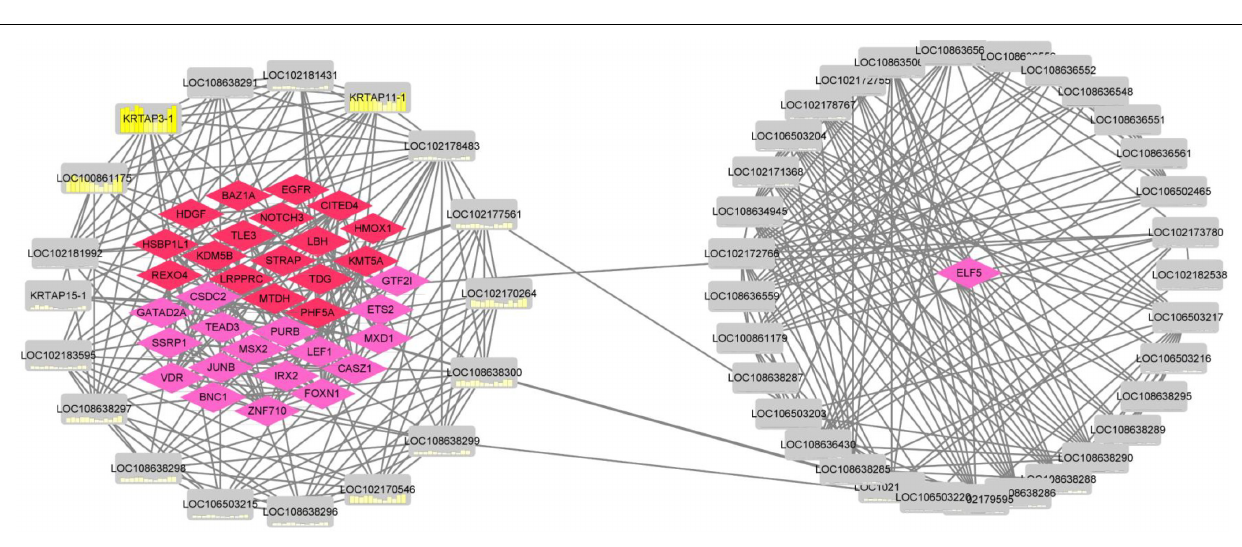
FIGURE 8 | Coexpression regulatory network of high-sulfur protein gene, transcription factor, and transcription cofactor. The red node represents transcription factor, the pink node represents transcription factor cofactor, and the gray node represents high sulfur protein gene. The yellow node shows the expression over 12